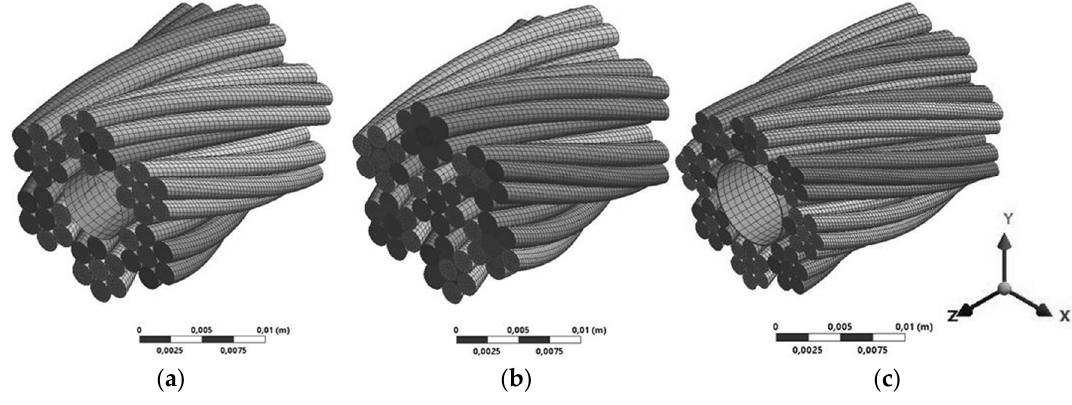
Figure 3. FE model of ( a ) 6 × 7 fiber core wire rope; ( b ) 7 × 7 wire rope; ( c ) 8 × 7 fiber core wire rope.